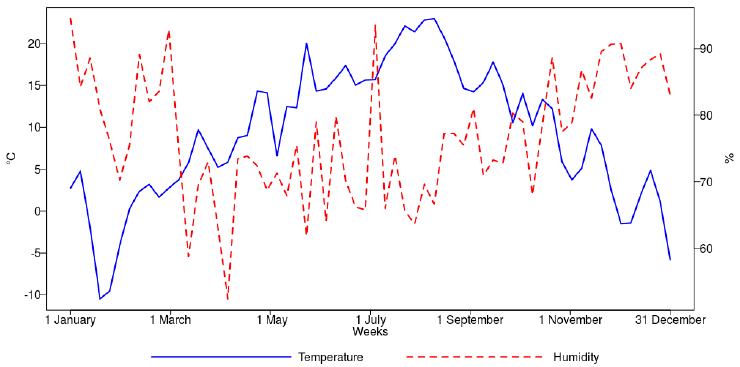
Figure 3. Weekly average temperature and humidity data in Warsaw in 2015.